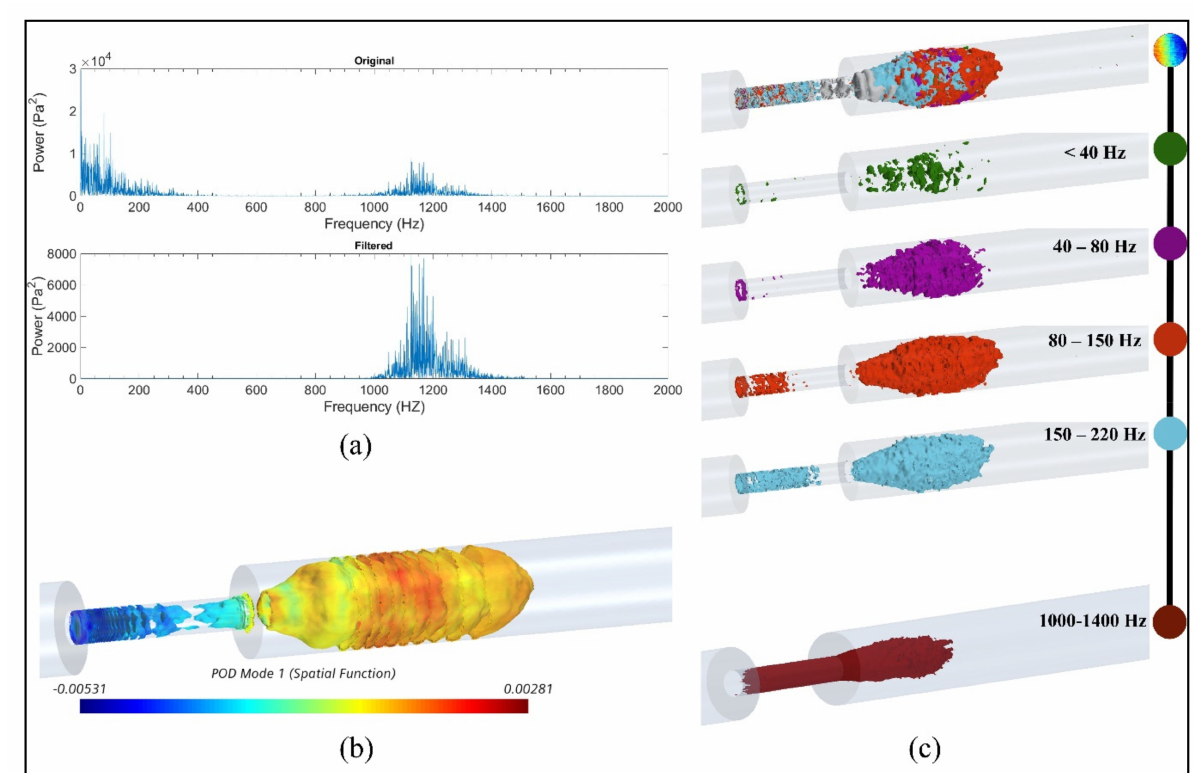
Figure 10. For 87% stenosis: ( a ) frequency content of the flow, ( b ) isosurfaces of proper orthogonal decomposition (POD) mode 1 of RMS of acoustic pressure, ( c ) snapshot of high-energy fluctuations for different frequency ranges and the bandwidth of 1000–1400